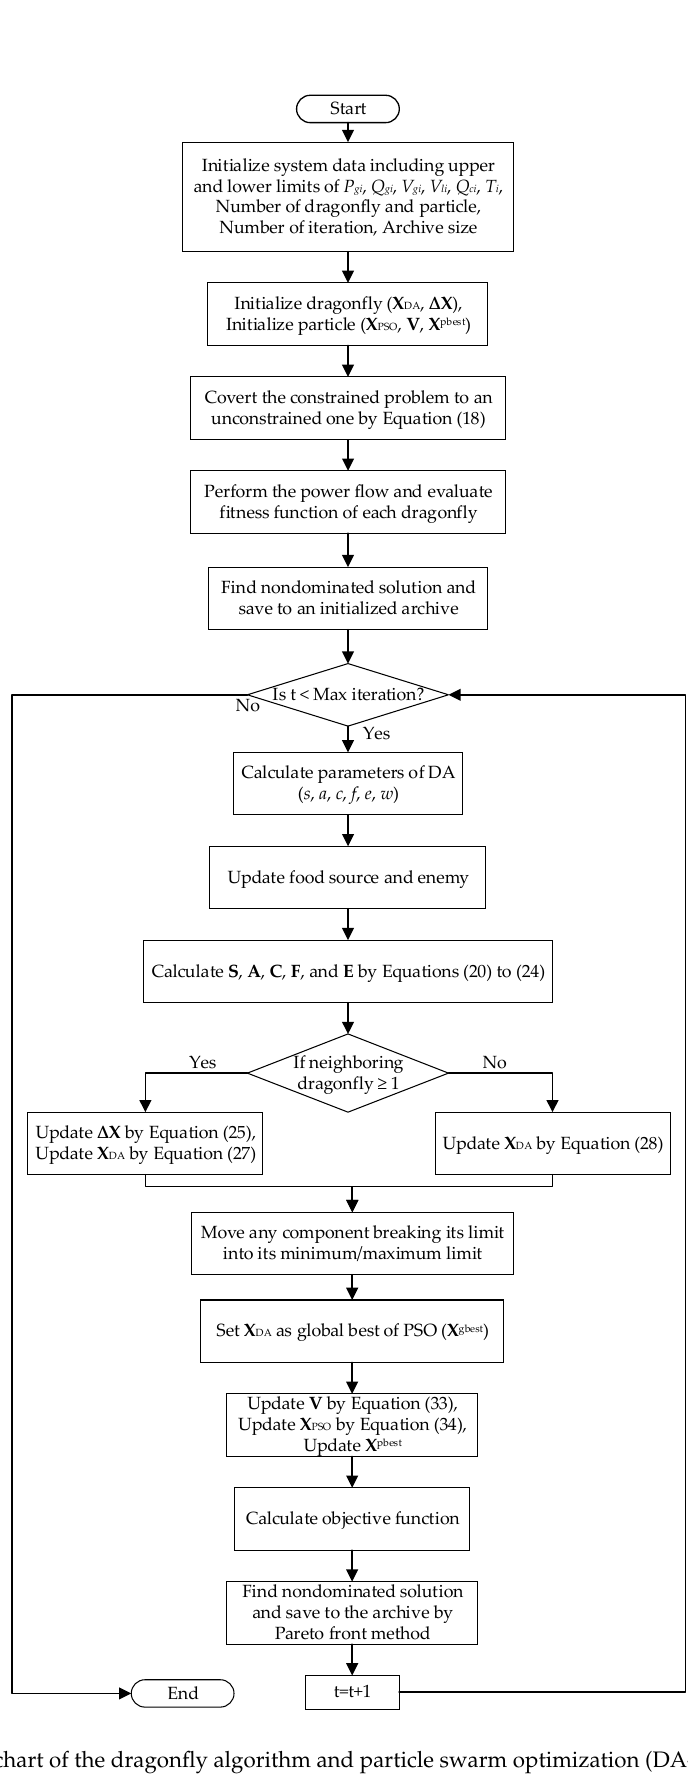
Figure 1. Flowchart of the dragonfly algorithm and particle swarm optimization (DA-PSO) algorithm for solving the multiobjective optimal power flow (MO-OPF) problem.